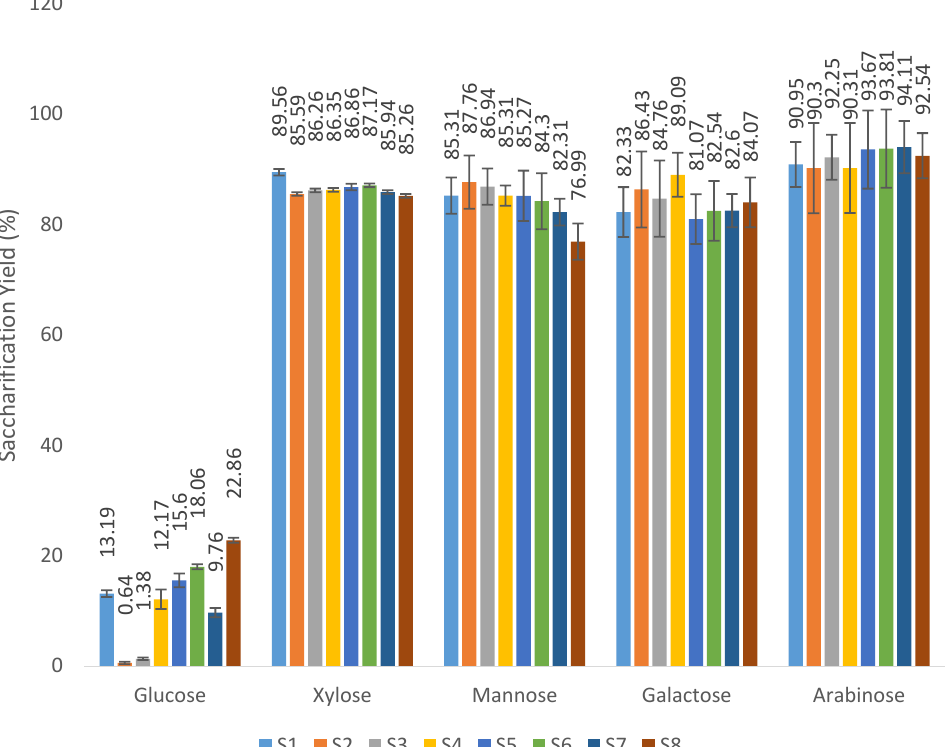
Figure 3. Saccharification yield in liquid fraction.